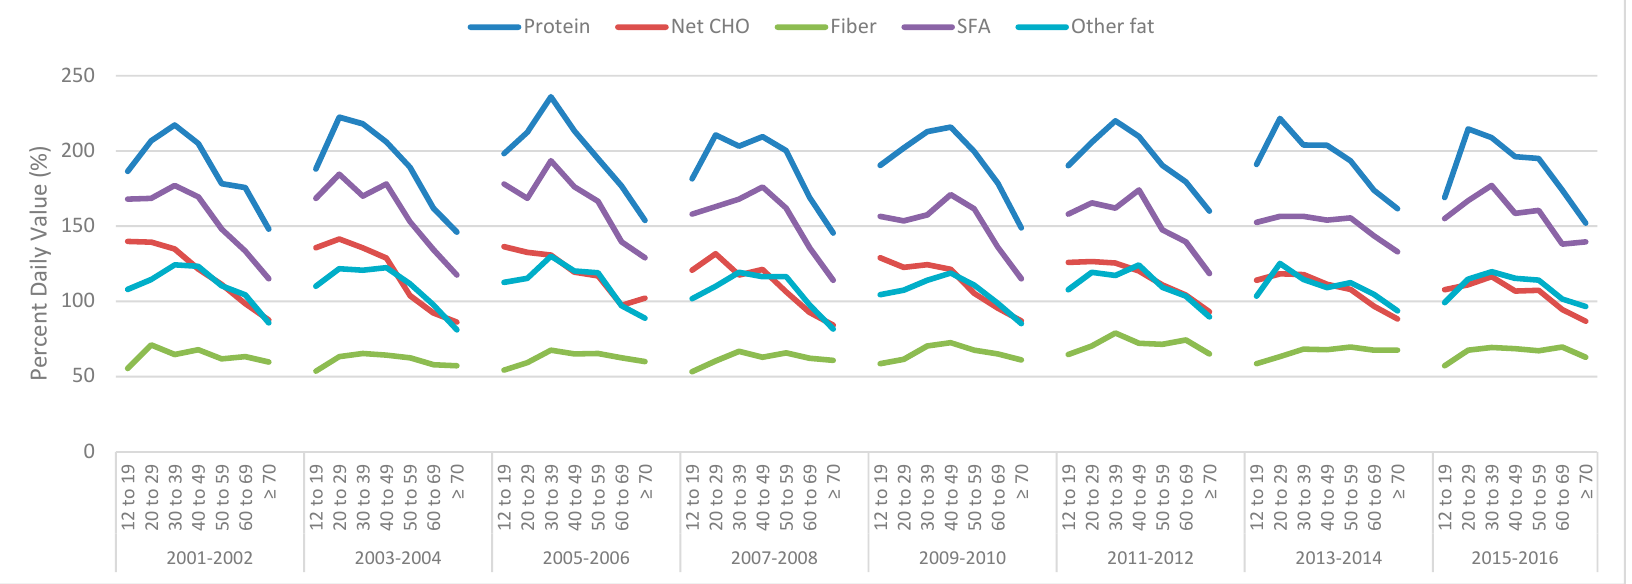
Figure 2. Mean daily male total protein, net carbohydrate (CHO), fiber, saturated fatty acids (SFA), and other fat intakes derived from the National Health and Nutrition Examination Survey (NHANES) 2001–2016 data across various age groups as a percentage of the daily value (100% = daily value).